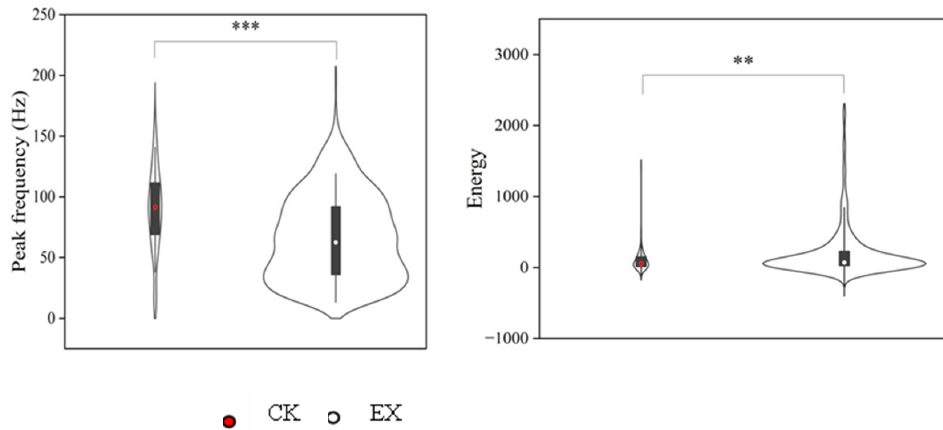
Figure 7. Comparison of the main peak frequencies and energies of the vibration signals of plateau zokors within the natural and artificial tunnels. In the violin plot, the lower and upper edges of the box represent the 25% (q1) and 75% (q3) quartiles, respectively. The points inside the box represent the median (md). The whiskers extend to the most extreme values within inner fences, md ± 1.5 (q3 − q1). Note: **p<0.01; ***p < 0.001. CK: natural tunnels; EX: arti fi cial tunnels.